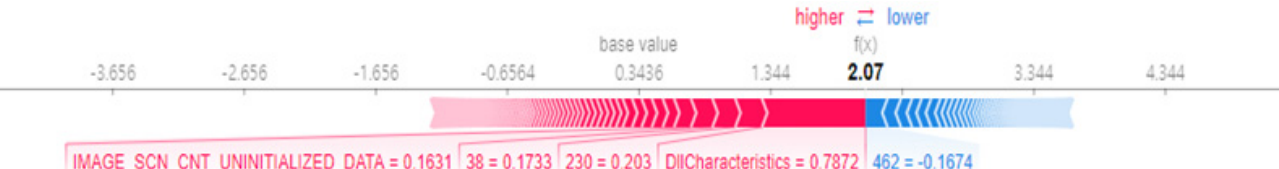
Figure 2. Force plot to provide the explainability of a single-model prediction.